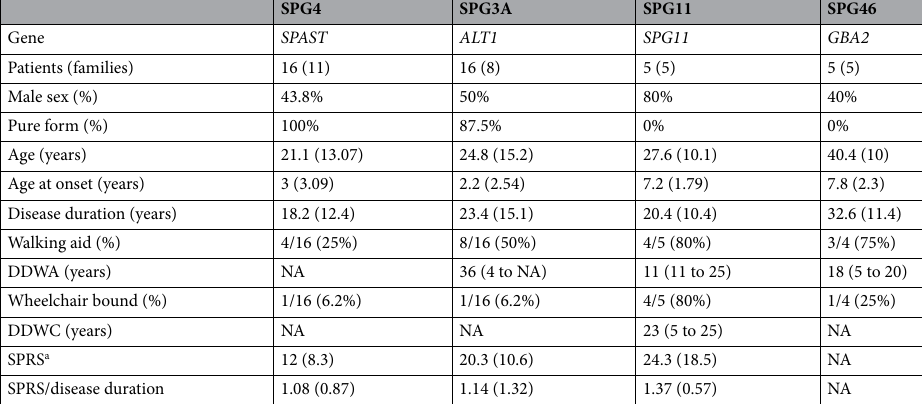
Table 1. Clinical characteristics of most frequent childhood-onset HSP subtypes. Data are shown as mean and standard deviation, except for DDWA and DDWC in which data are shown as median and interquartile ranges. DDWA disease duration at walking aid dependency, DDWC disease duration at wheelchair dependency, HSP hereditary spastic paraplegias, SPRS spastic paraplegia rating scale. a Available for 11 cases with SPG4, 10 cases with SPG3A and 3 cases with SPG11.